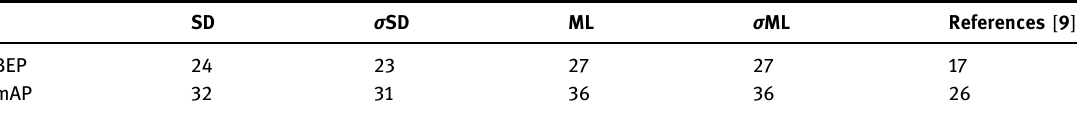
Table 4: Comparison between the algorithm model in this article ( K = 200 ) and the algorithm in the literature [ 9 ] in terms of mAP and BEP